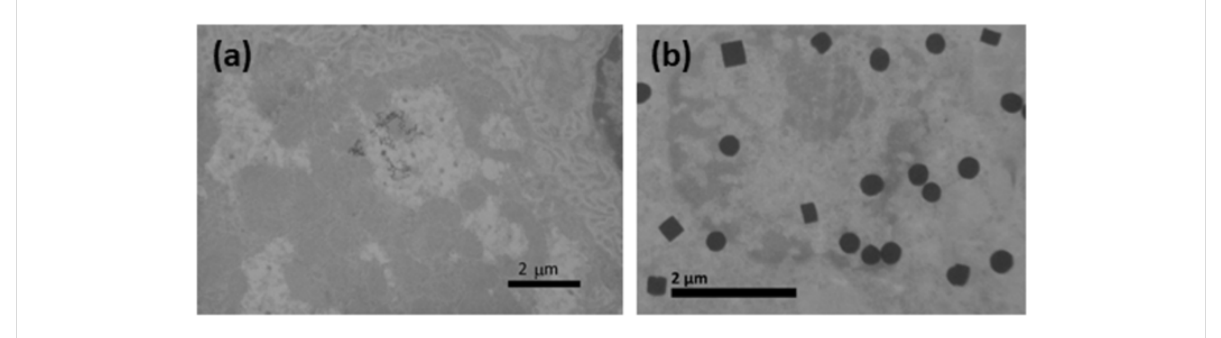
Figure 2: TEM images of liver obtained from (a) untreated and (b) treated healthy male Wistar rats. The rats were treated orally with a daily dose of 1 mg Ag/kg of body weight of PVP-coated AgNPs during 28